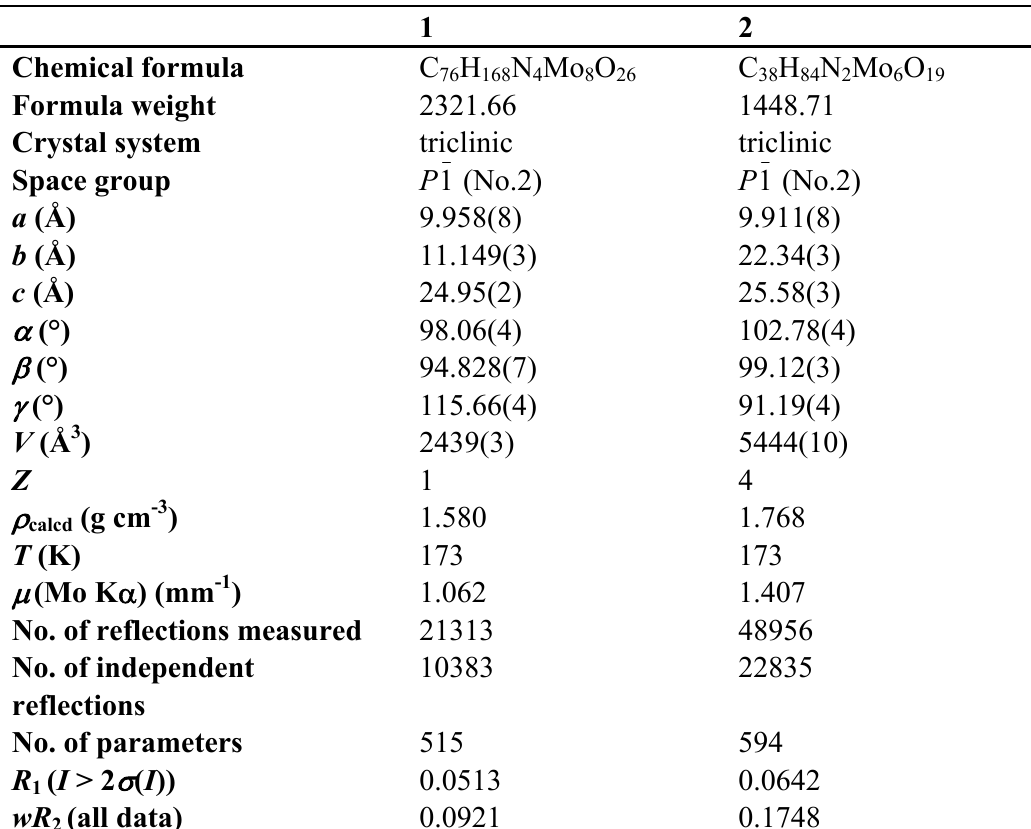
Table 1. Crystallographic data for 1 and 2